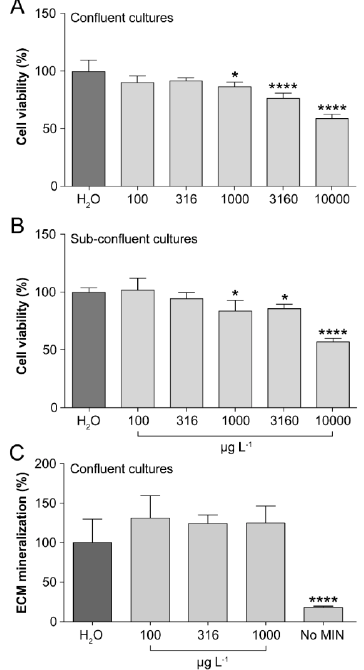
Figure 3. ( A ) Cytotoxicity and ( B ) proliferative effect of different concentrations of MON assessed in confluent or sub-confluent VSa13 cell cultures, respectively, through the XTT cell survival assay. Value of the vehicle was set at 100%; ( C ) Mineralogenic effect of MON (highest non-toxic concentrations) assessed in mineralizing VSa13 cell cultures through alizarin red S staining. Changes in extracellular matrix (ECM) mineralization are shown as an x -fold change over the control. Asterisks indicate values statistically different from the vehicle (one-way ANOVA followed by Dunnett’s multiple comparison test (* p ≤ 0.05; **** p ≤ 0.0001). Data presented as average ± SD of average. No MIN: Medium without mineralization